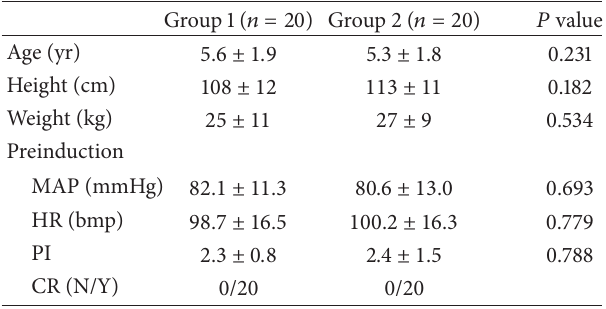
Table 1: Demographic data and baseline value in all